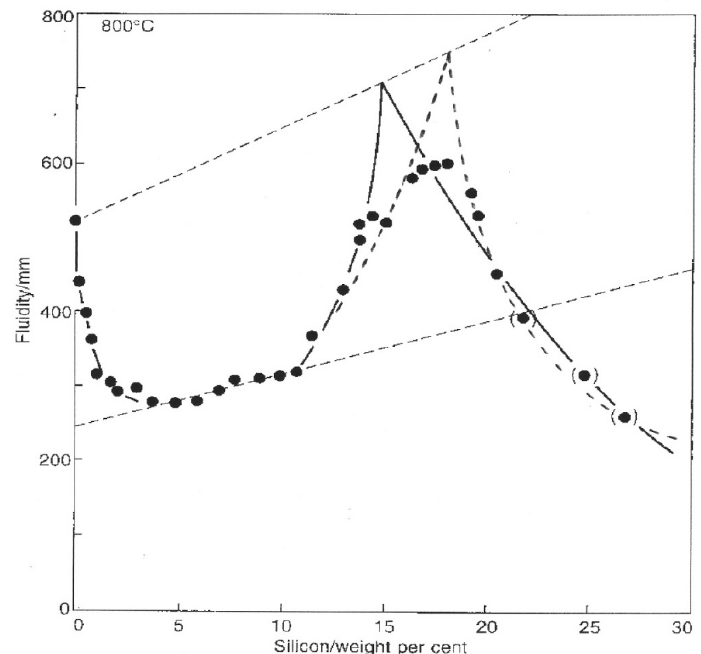
Figure 9. Typical fluidity results for Al–Si alloys showing a peak somewhere between 14 and 18 wt.% Si (data from Lang [20]) (the suggested linear limits are by the author [2]). Si (data from Lang [20]) (the suggested linear limits are by the author